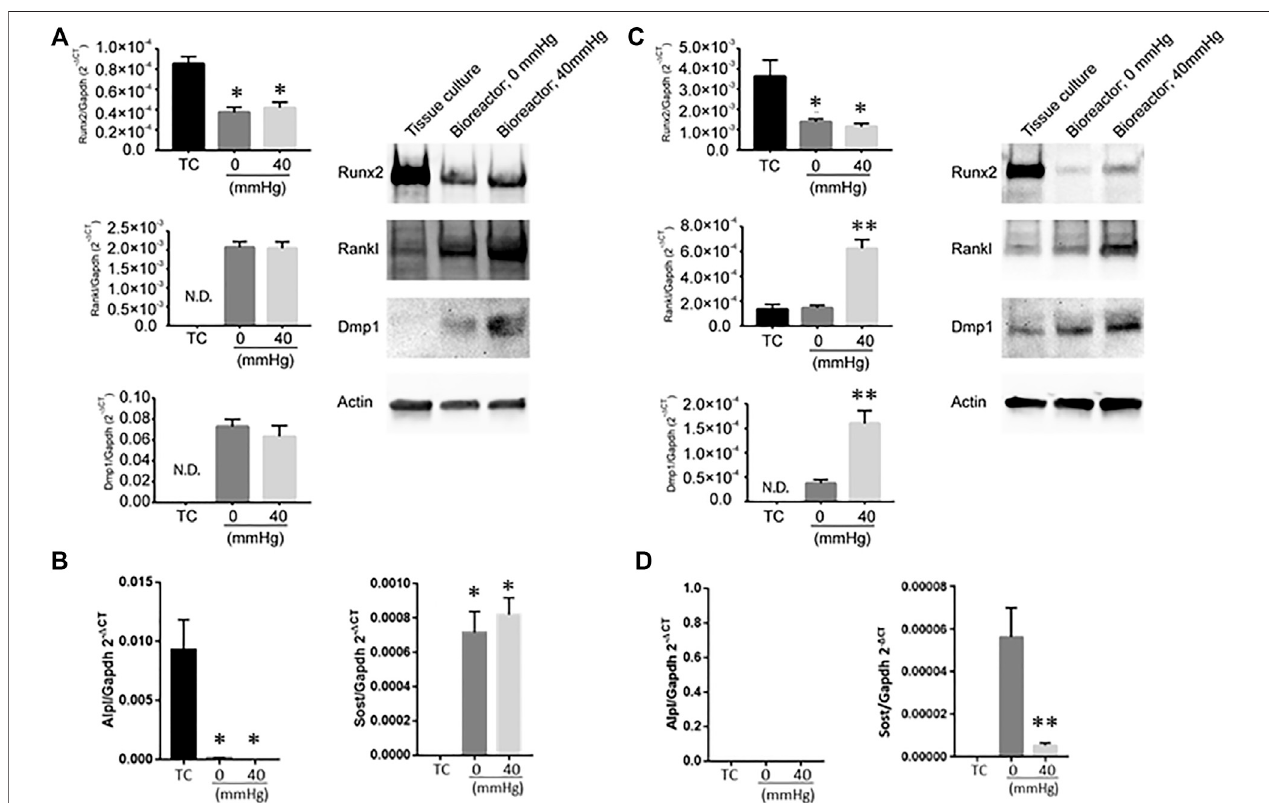
FIGURE3 | Expression ofbone remodeling genesin responsetochangesin pressure. (A) Dmp1, Rankl and Runx2 mRNA levels (left) and protein (right) in MC3T3 when grown under different conditions (tissue culture plate (TC); bioreactor at 0 mmHg; bioreactor at 40 mmHg). (B) Alpl (left) and Sost (right) transcript levels in MC3T3 cells grown on TC, bioreactor with no pressure added (0 mmHg) or with 40 mmHg pressure added. (C) Dmp1, Rankl and Runx2 mRNA levels (left) and protein (right) in MLO-Y4 ′ whengrownunderdifferentconditions(TC;bioreactorat0 mmHg;bioreactorat40mmHg). (D) Alpl(left)andSost(right)transcriptlevelsinMLO-Y4cells grown on TC, bioreactor with no pressure added (0 mmHg) or with 40 mmHg pressure added. Dataare presented as mean ± SD from three independentexperiments. * p ≤ 0.05 vs. TC; ** p < 0.05 vs. bioreactor at 0